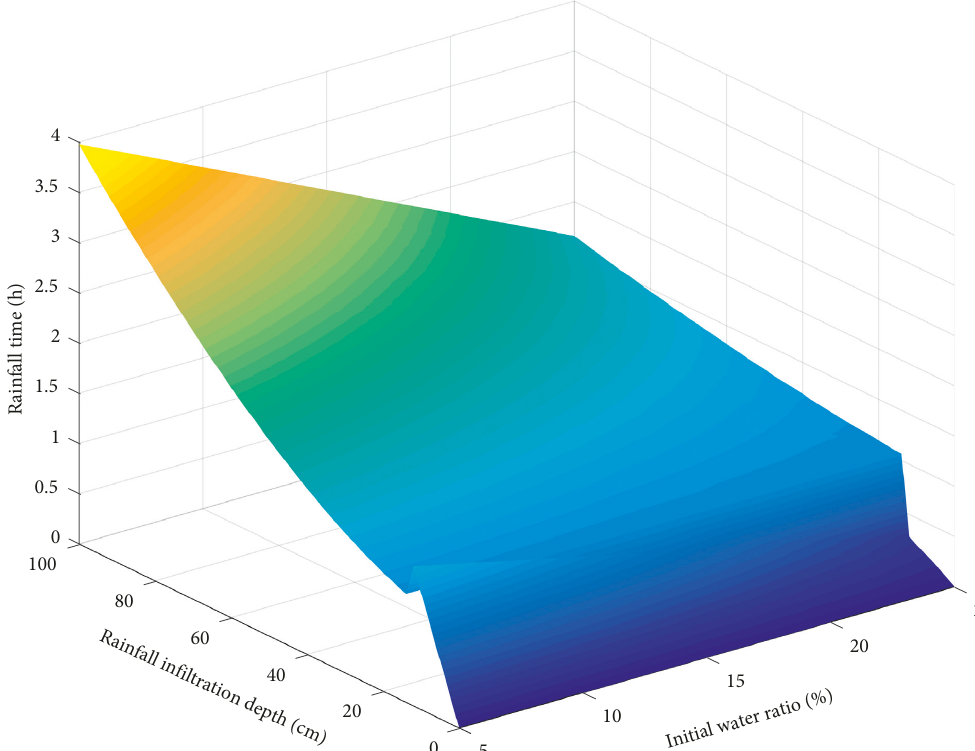
Figure 15: Variation of rainfall infiltration depth in the tailing slope with the changes of rainfall duration and initial water